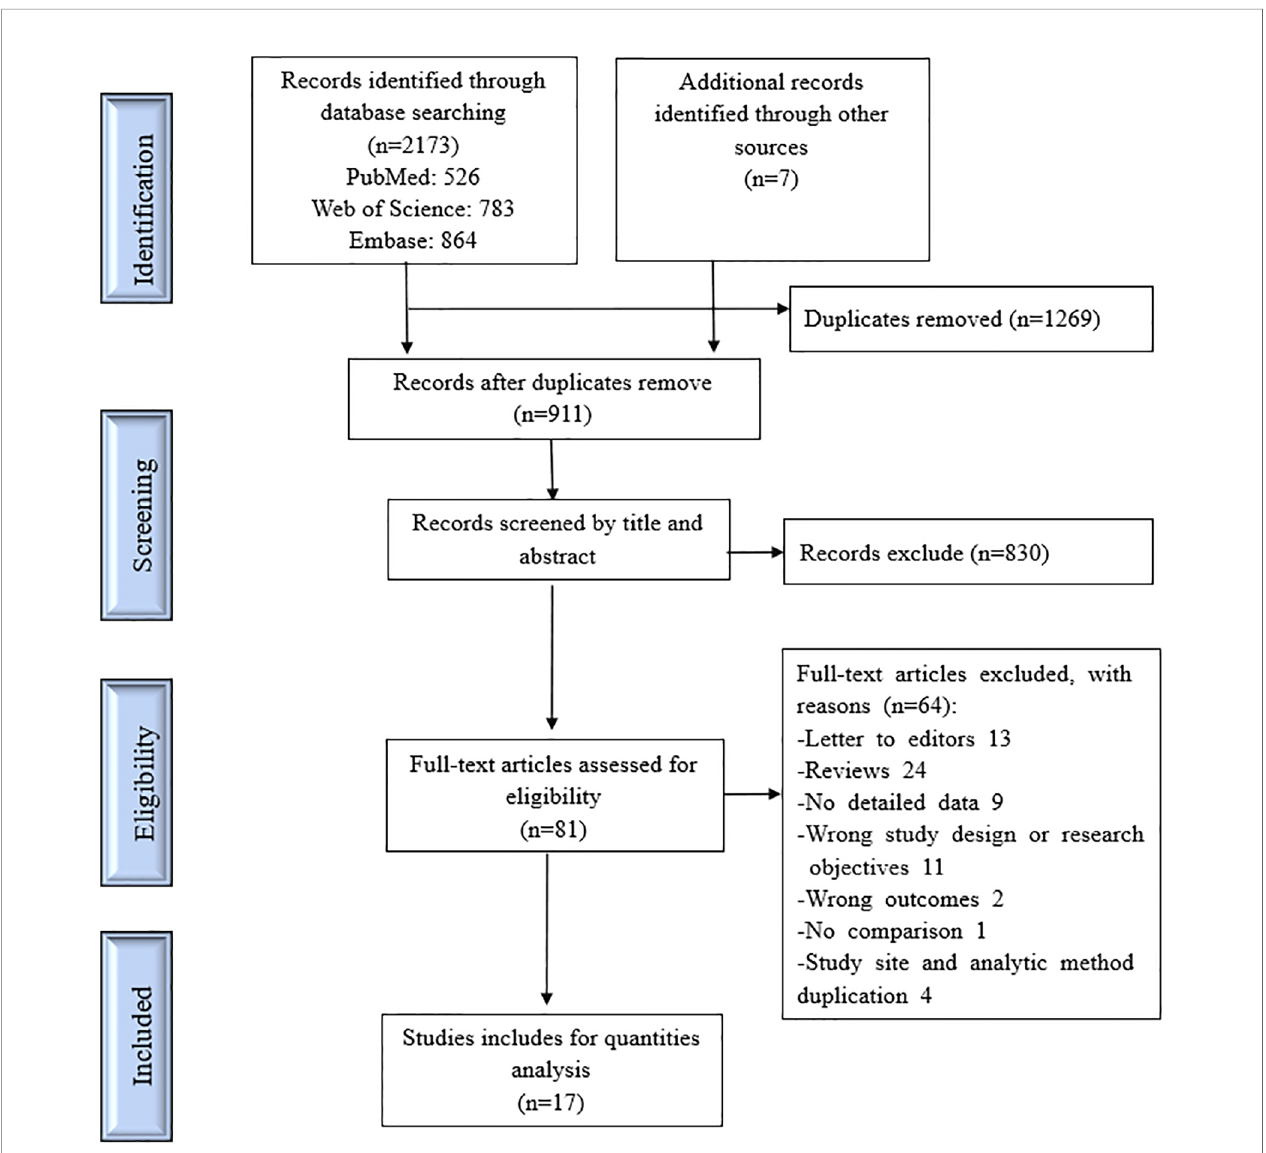
FIGURE 1 | Flow diagram of publication selection